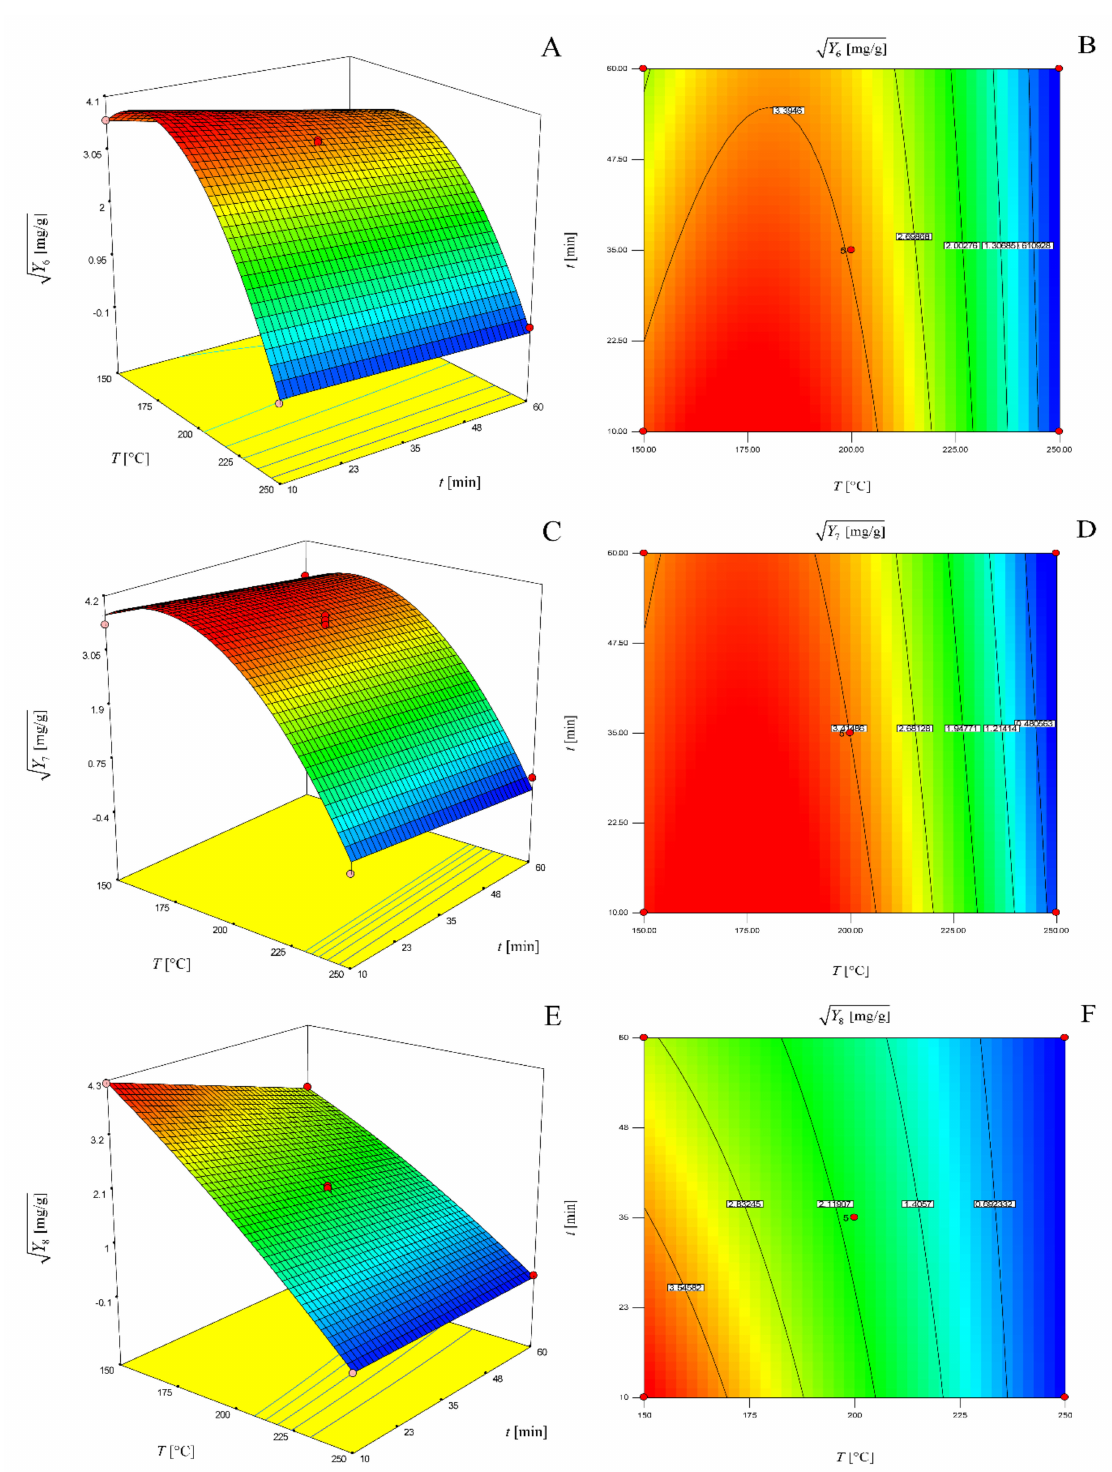
Figure 4. Three-dimensional response surface ( a ) and two-dimensional contour plot ( b ) of the model for determination of glucose yield for a solvent–solid ratio of 20 mL / g; three-dimensional response surface ( c ) and two-dimensional contour plot ( d ) of the model for determination of fructose yield for a solvent–solid ratio of 20 mL / g; three-dimensional response surface ( e ) and two-dimensional contour plot ( f ) of the model for determination of maltose yield for a solvent–solid ratio of 20 mL /